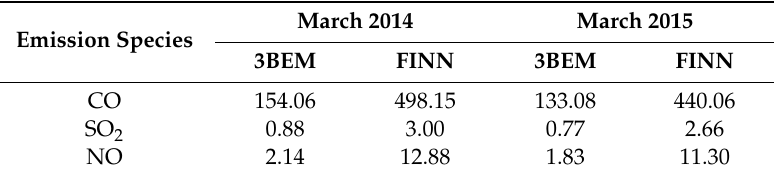
Table 10. Daily total 3BEM and FINN emissions (kg m − 2 day − 1 ) of CO, SO 2 , and NO averaged over the study area and over 31 days in March of 2014 and